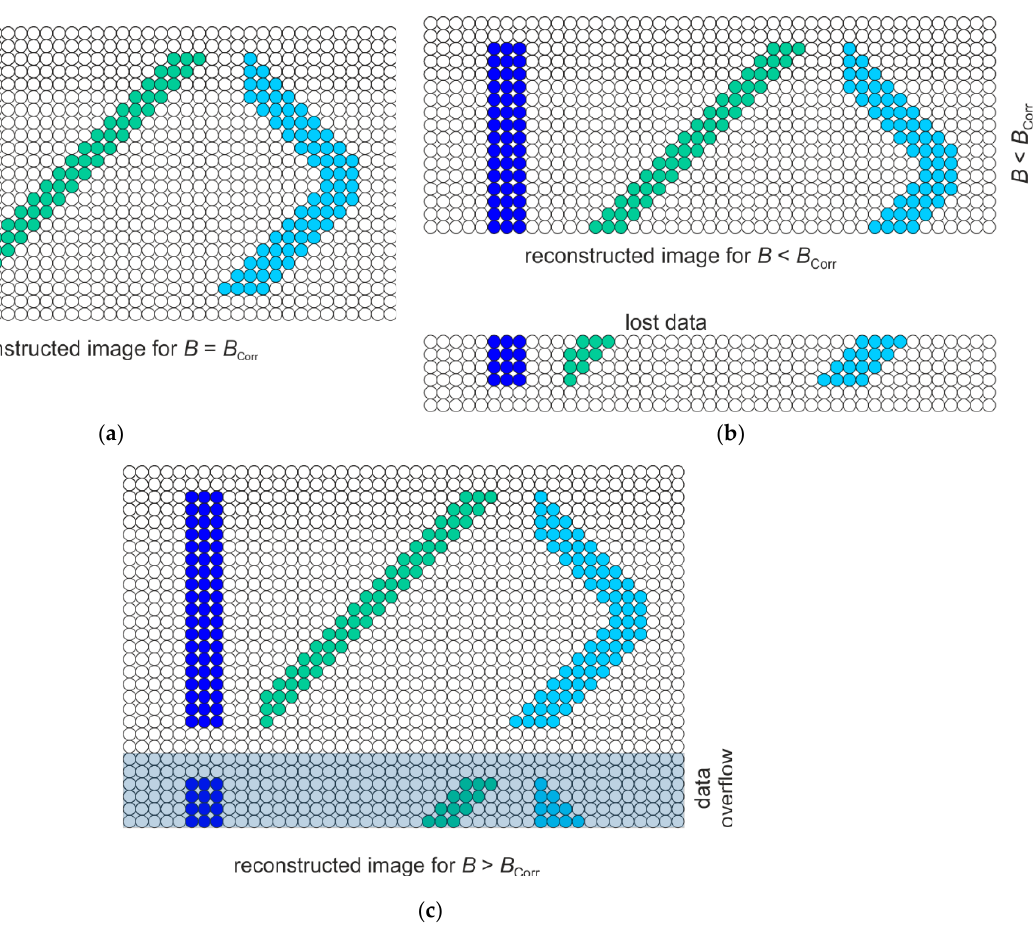
Figure 3. Illustrating the effect of the number lines of image on its content: ( a ) correct number lines of the image, ( b ) too few lines of the image, ( c ) too many lines of the